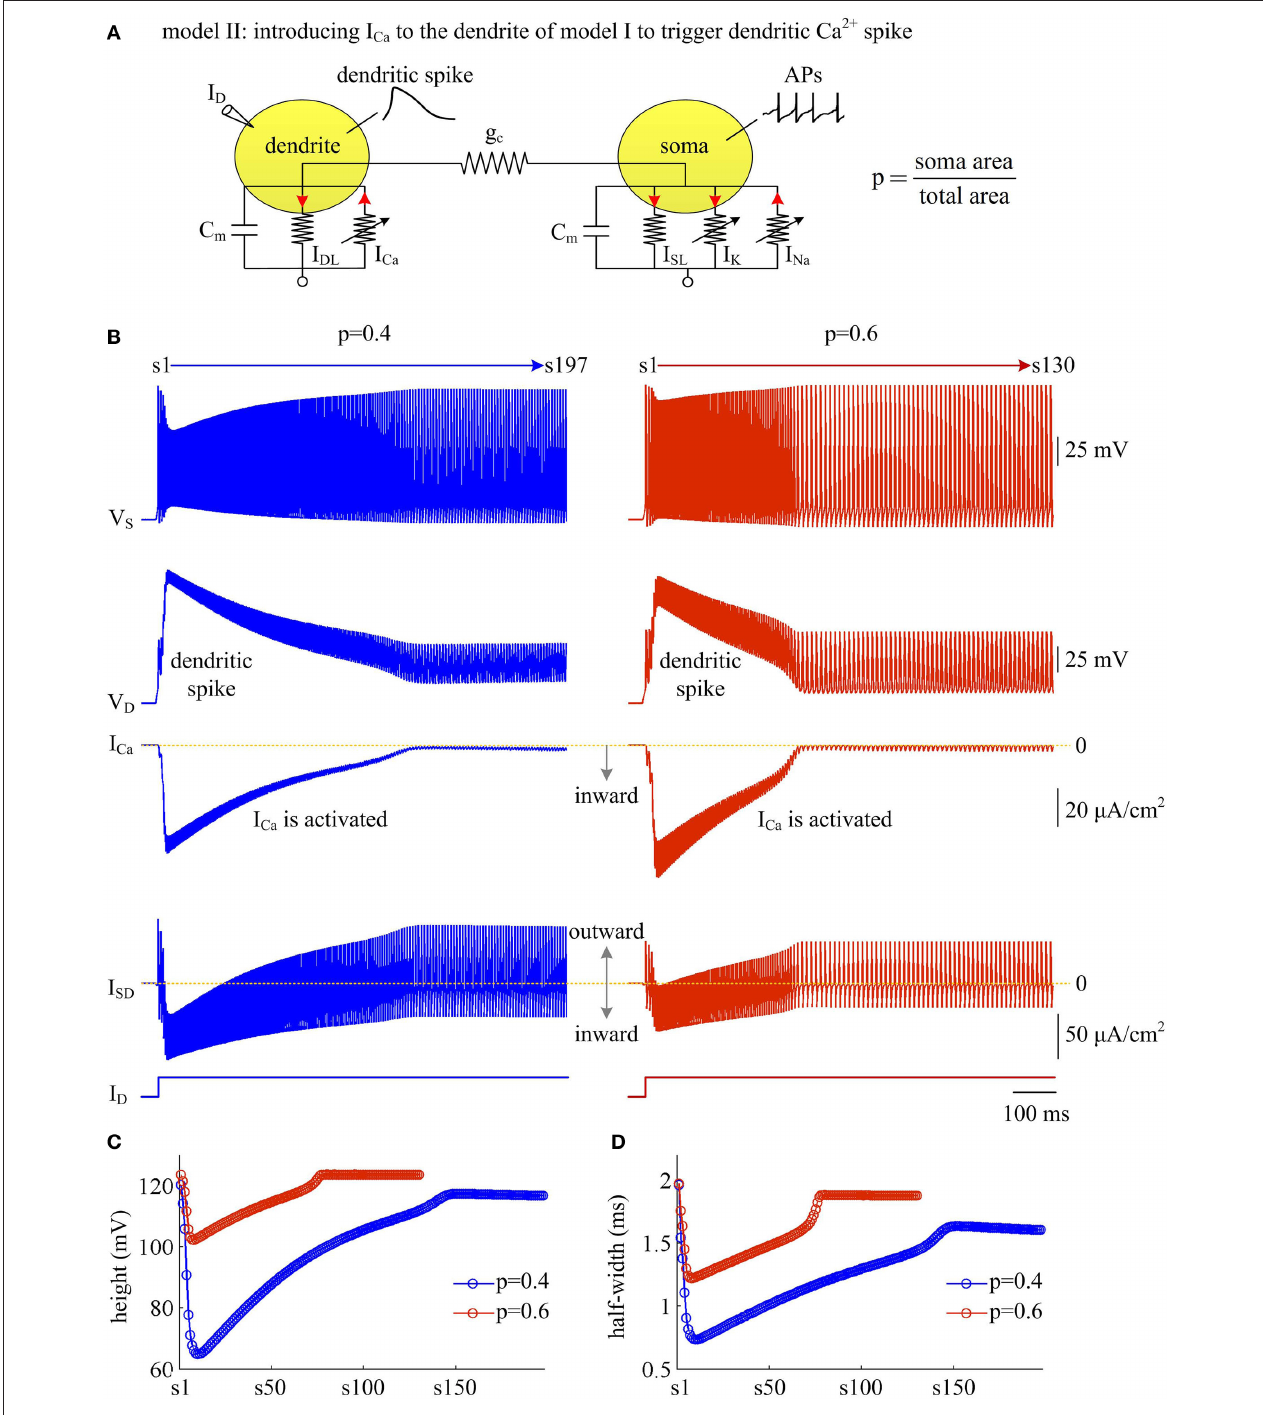
FIGURE 6 | Activating Ca 2 + current in dendritic chamber results in dendritic spike in model II. (A) Schematic of model II. An inward Ca 2 + current I Ca is introduced to the dendritic chamber of model I. (B) Sample responses recorded in the soma with p = 0.4 and 0.6. Somatic voltage V S , dendritic voltage V D , Ca 2 + current I Ca and internal current I SD are plotted against time. With p = 0.4 (left), there are 197 APs generated during the interval of 1,000 ms, and we number them s1 through s197 from left to right. With p = 0.6 (right), there are 130 APs during the interval of 1,000 ms, and we number them s1 through s130 from left to right. (C) The height of each AP with p = 0.4 and 0.6. (D) The half-width of each AP with p = 0.4 and 0.6. Note that both height and half-width show marked decrease during the course of dendritic Ca 2 + spike. I D = 5 µ A / cm 2 and g c = 0.3 mS / cm 2